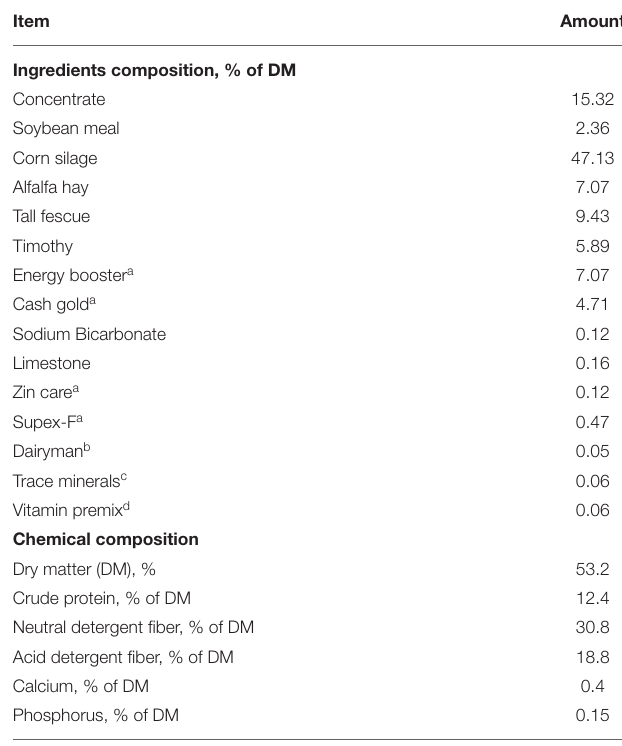
TABLE 1 | Ingredients and nutrients of total mixed rations used in this